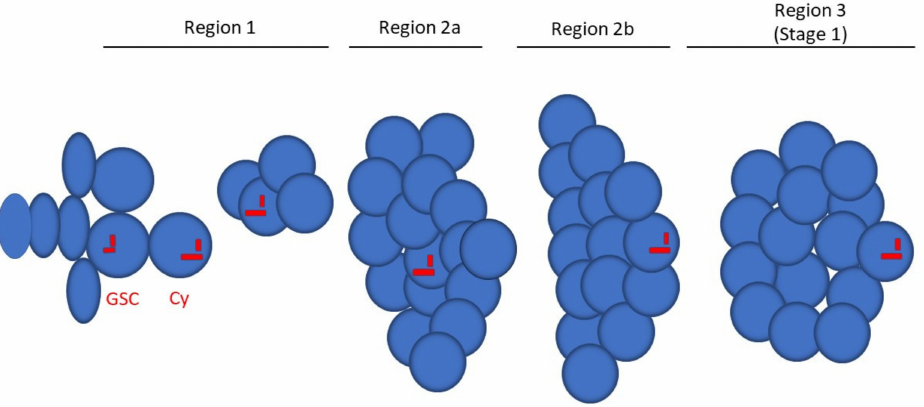
Figure 6. Schematic drawing of the early stages of oogenesis in the Drosophila germarium depicting the localization of the elongated centriole (GSC, germline stem cell; Cy, cystoblast). The elongated centriole displays a cartwheel that extends for the entire length of its wall. This aspect contrasts with the architecture of the centrioles found during Drosophila spermatogenesis. Male GSCs, spermatogones and young primary spermatocytes,